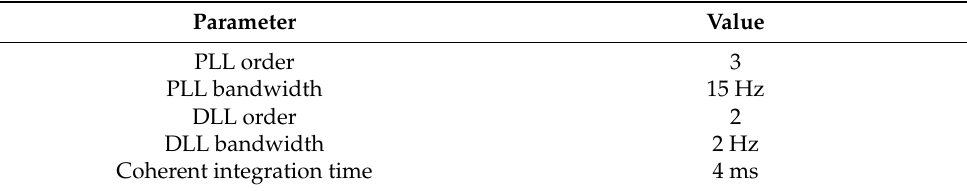
Coherent integration time 4